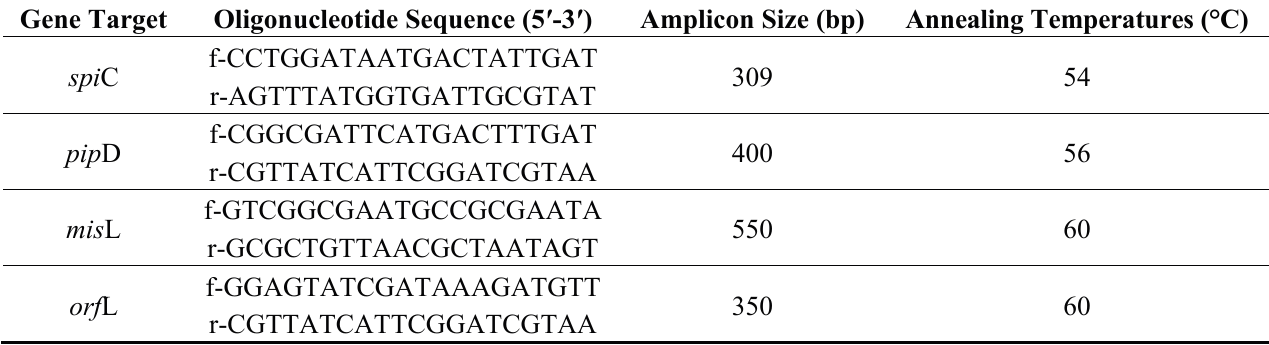
Table 1. Primer used for the detection of virulence genes in Salmonella spp. recovered from treated wastewater effluent and receiving surface